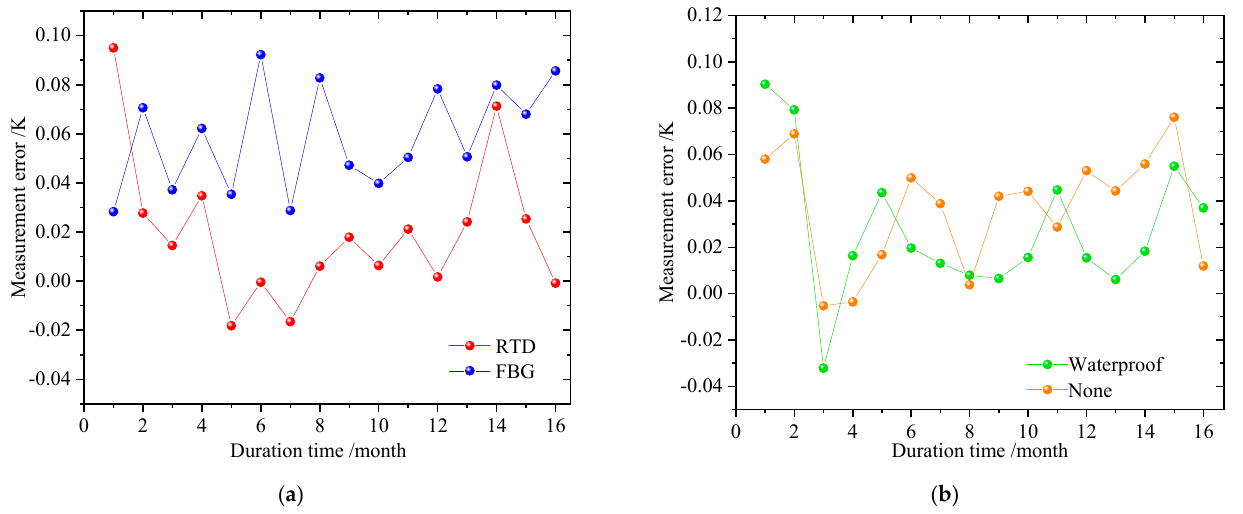
Figure 9. Measurement results: ( a ) long period monitoring for marine chiller system; ( b ) influence of humidity on temperature reading accuracy of FBG. Table 1. Influence of insertion depth on temperature sensor measurement.